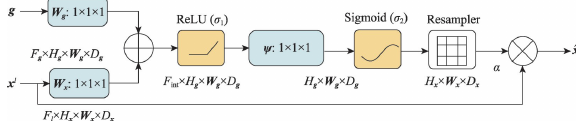
Fig. 4. Attention mechanism